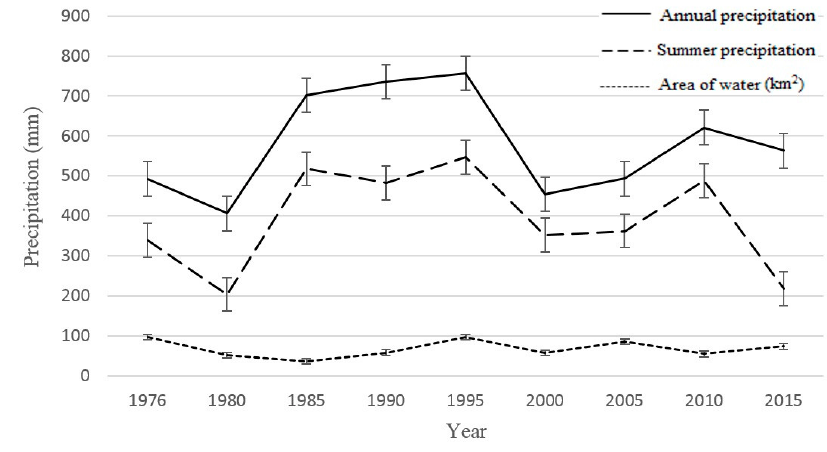
Figure 8. The relationship between the water area and precipitation (annual and summer